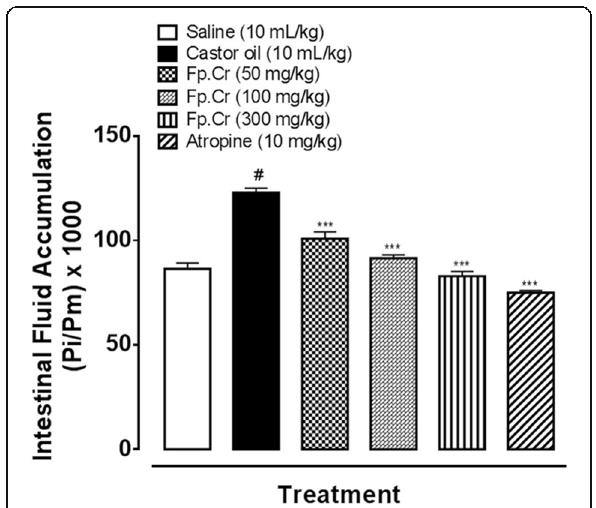
Fig. 3 Inhibitory effect of Ficus palmata crude extract (Fp.Cr) and atropine on castor oil induced fluid accumulation in mice. Results are expressed as mean ± SEM, n = 5. Anti-secretory effect is expressed as Pi/Pm × 1000 (g) where Pi is the weight of the small intestine and Pm is the weight of mouse; # p < 0.001 vs. saline group, *** p < 0.001 vs. castor oil group, one-way analysis of variance with post-hoc Tukey ’ s